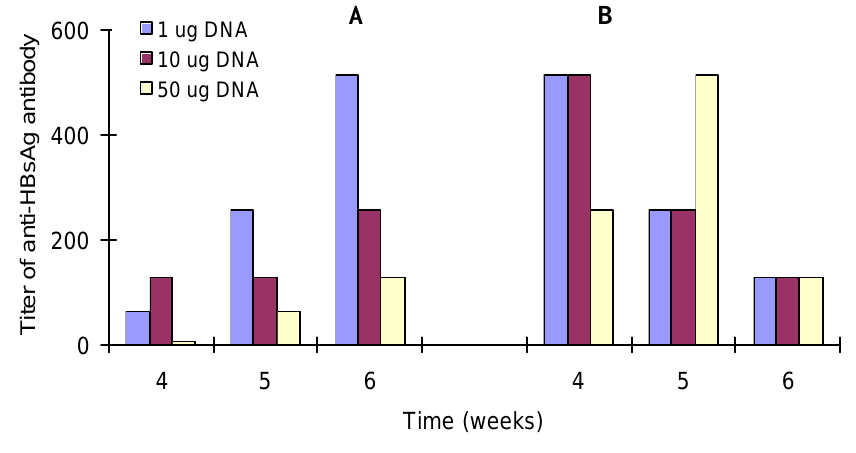
Figure 2. The titer of anti-HBsAg antibody by skin (A) and by i.p inoculation (B). Table 1. The ratio and the percent of high positive immune responses by skin and i.p inoculation. Skin inoculation i.p inoculation